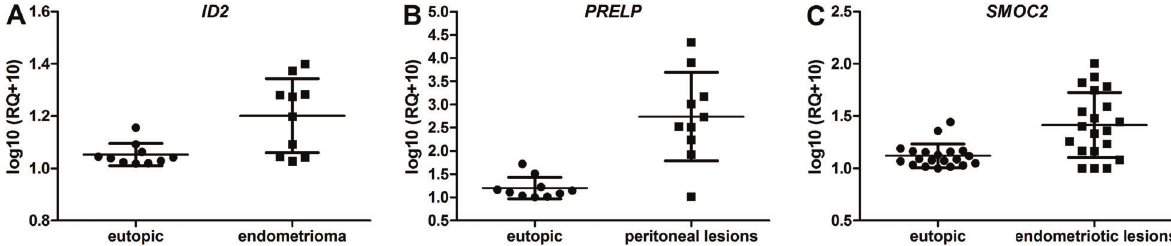
Figure 2. Expression levels of ID2 ( A ), PRELP ( B ) and SMOC2 ( C ) genes in the eutopic endometrium and endometriotic lesions (endometrioma, peritoneal lesions and endometriotic lesions) of women with endometriosis. Horizontal lines indicate medians and interquartile